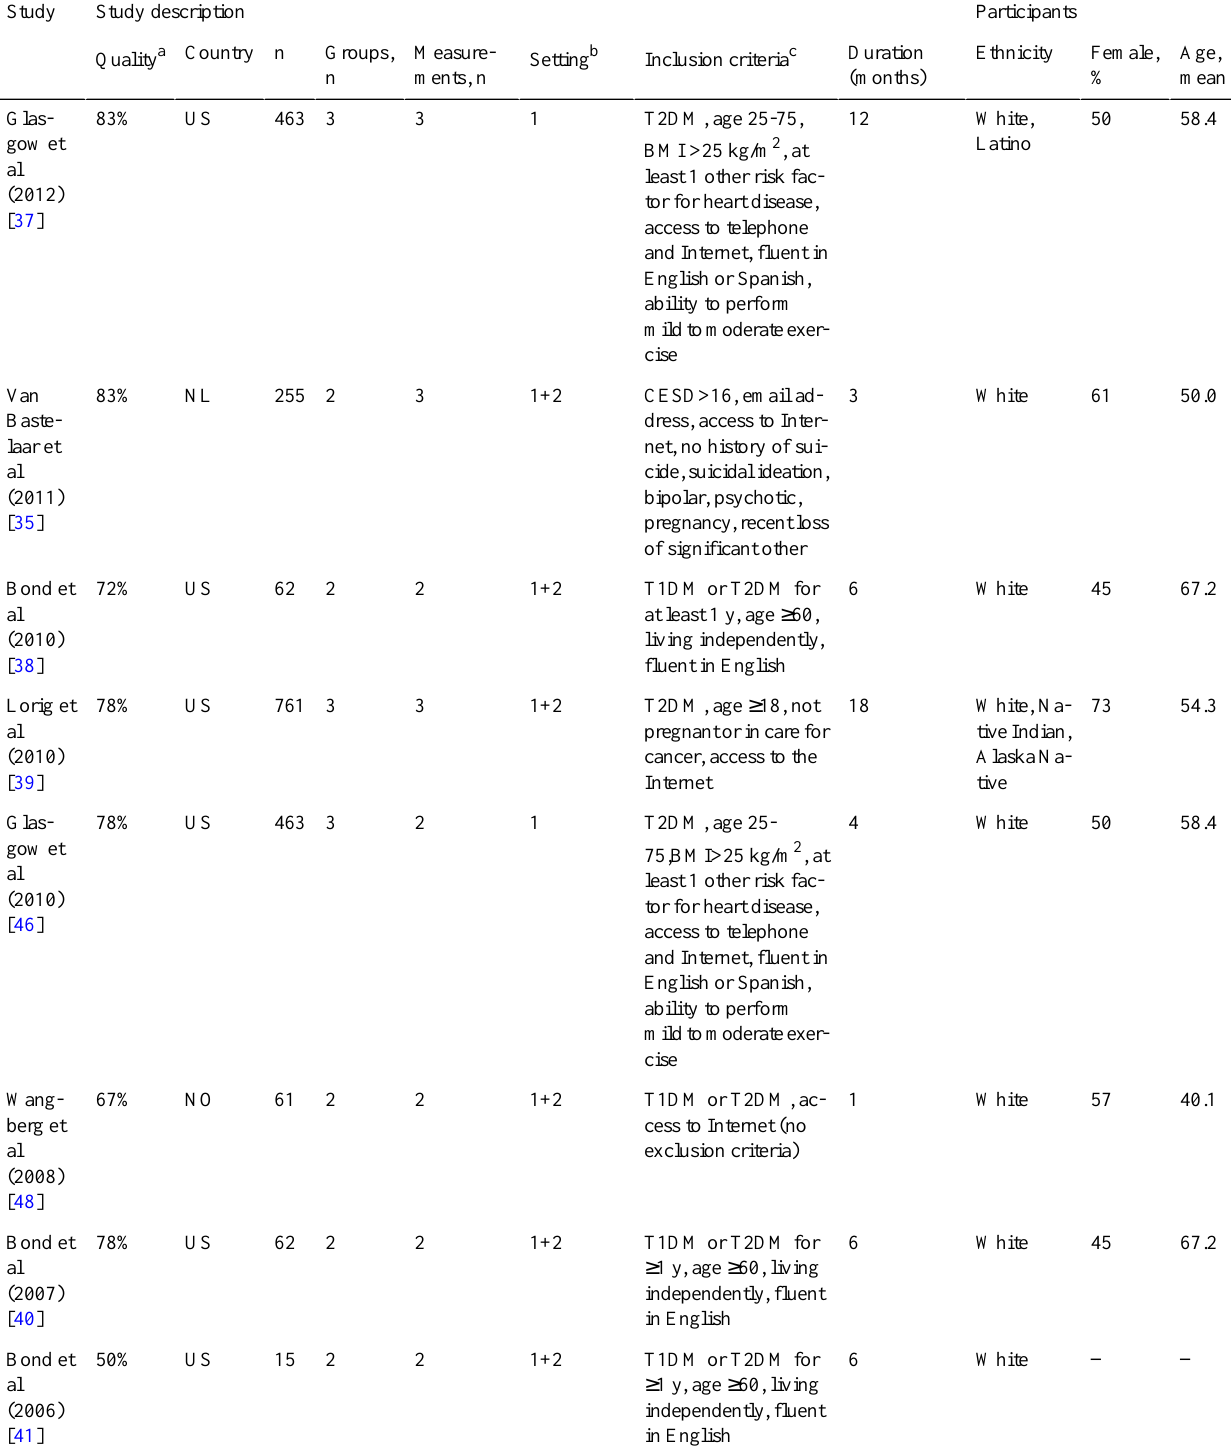
Table 1. Characteristics of the studies. ParticipantsStudy